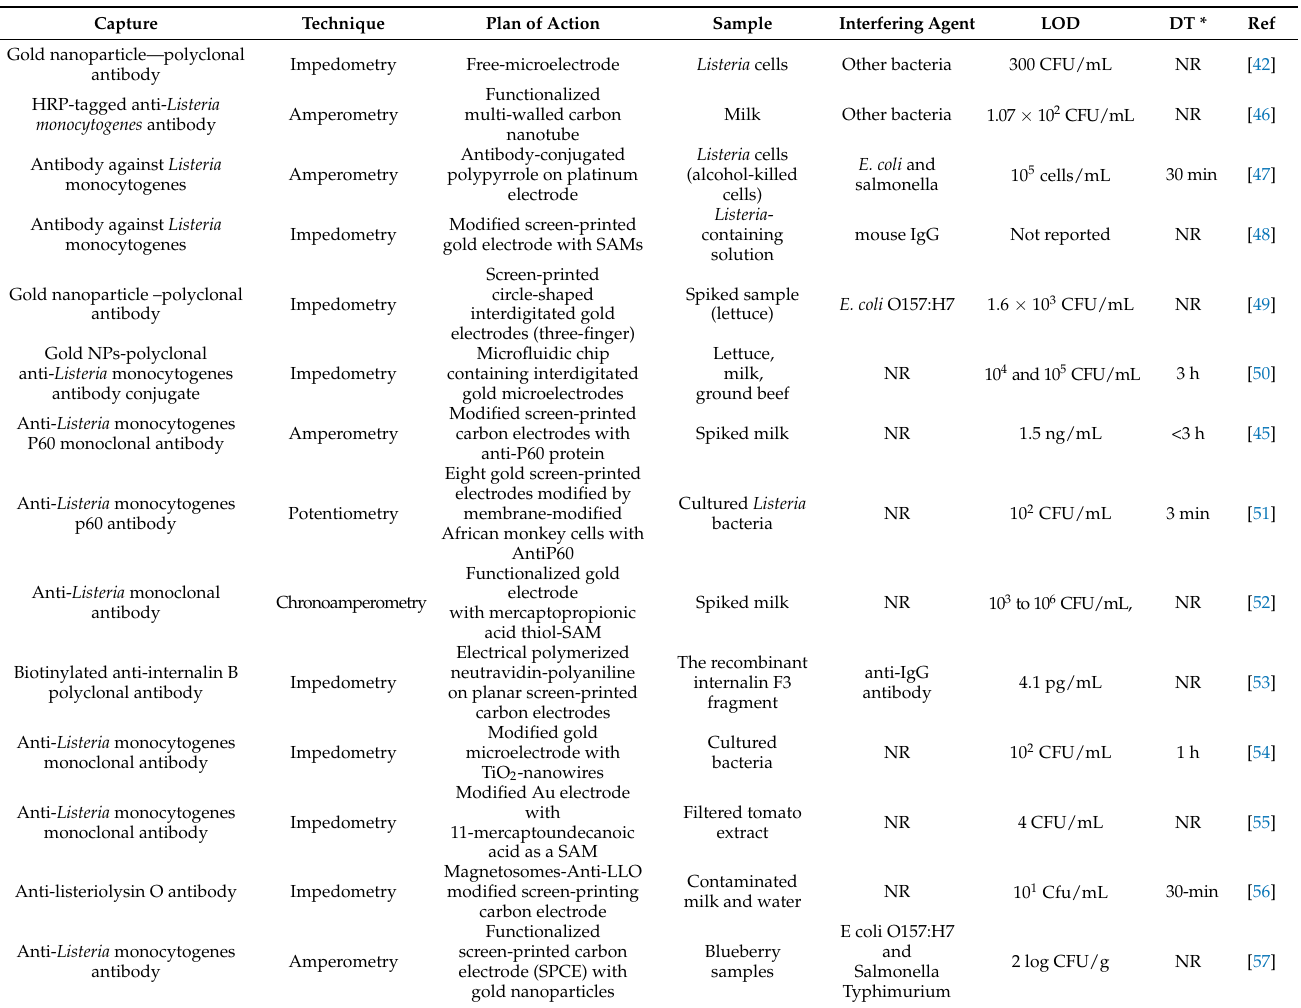
Table 1. Previously developed electrochemical immunosensors for Listeria monocytogenes